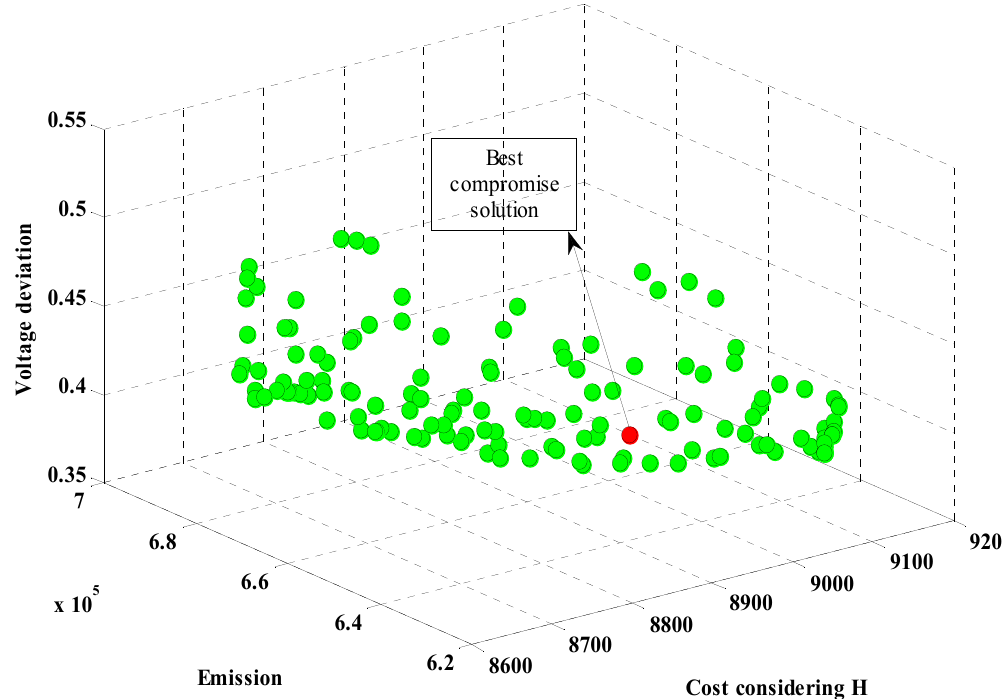
Figure 12. Pareto front for cost considering strategy 3, emission and voltage deviation objective functions.